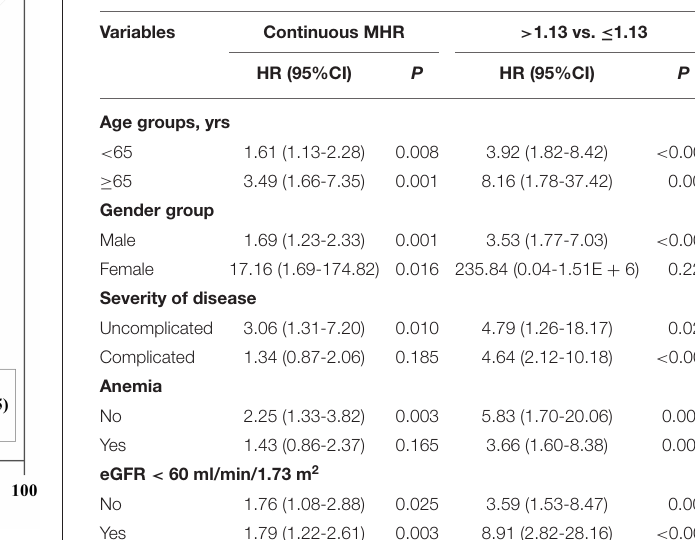
TABLE 3 | Association of preoperative monocyte to high-density lipoprotein ratio (MHR) on long-term death in subgroups after multivariable adjustment * .